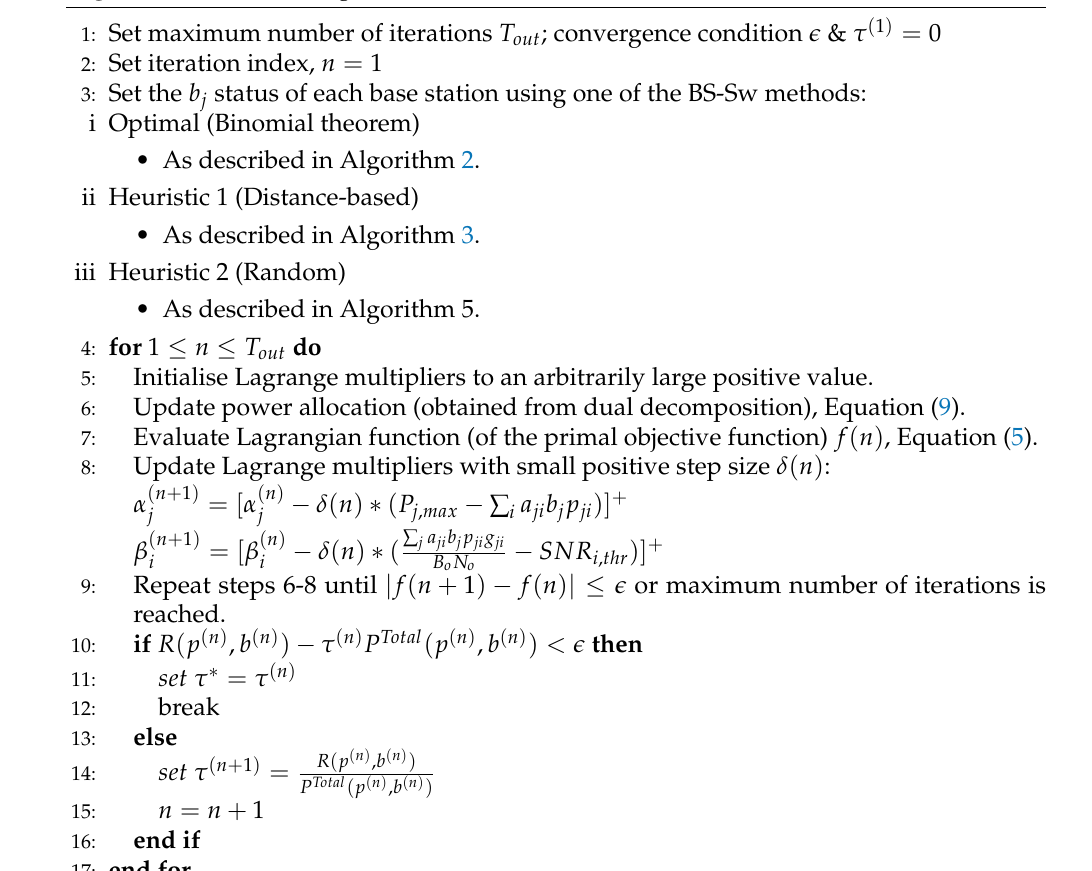
Algorithm 1 PABS-Sw